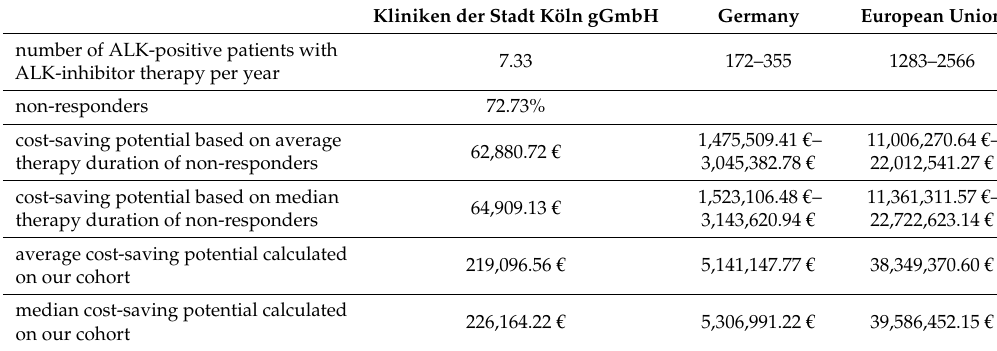
Table 3. Calculation of the yearly cost-saving